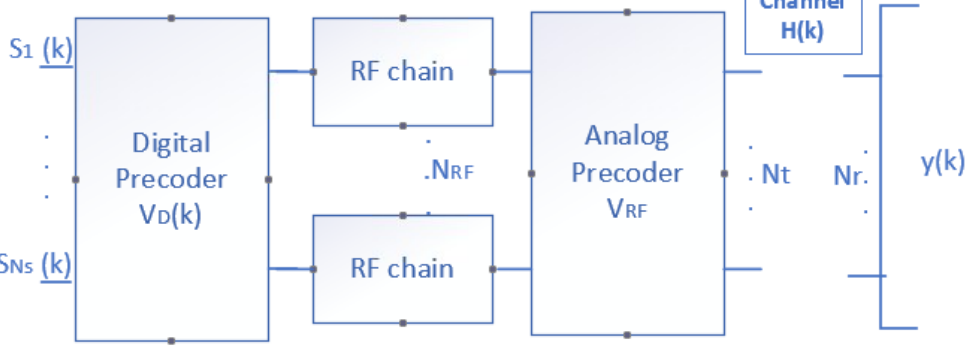
Figure 3. Block diagram of the HBF